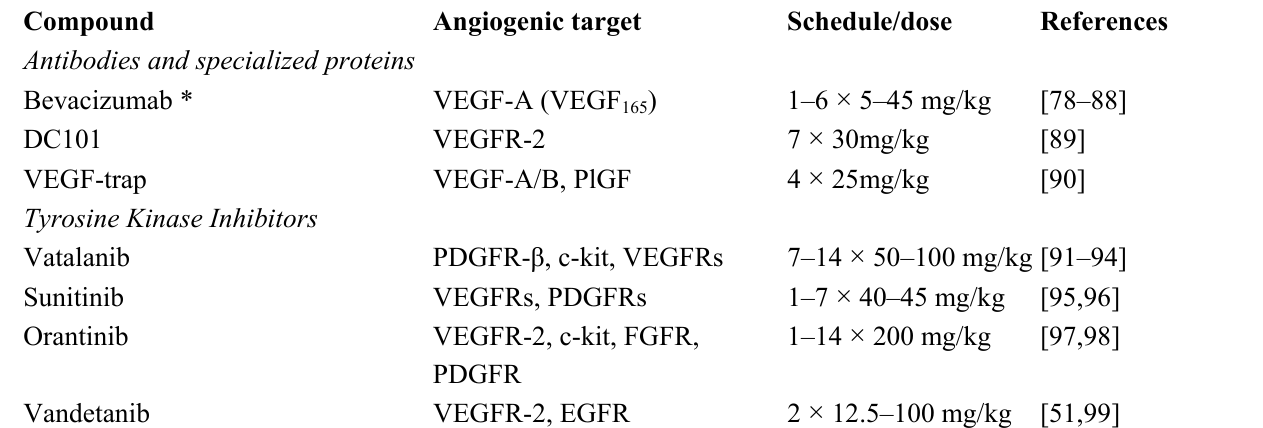
Table 1. Angiogenesis